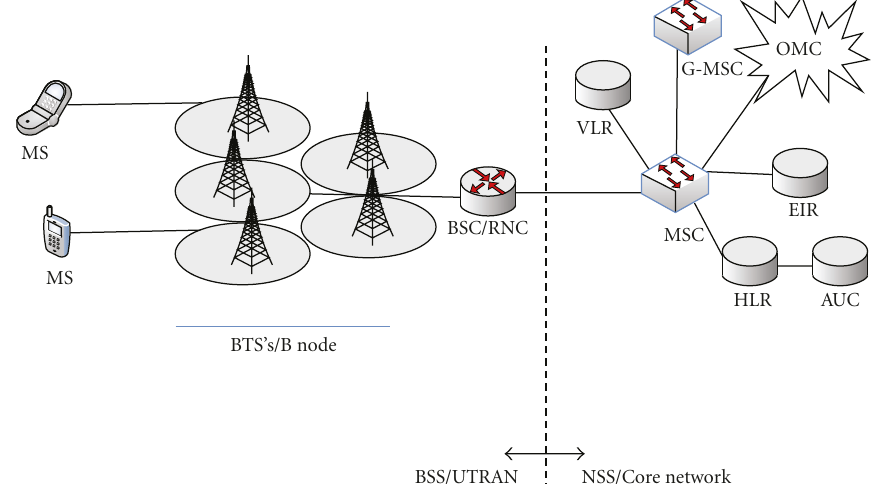
Figure 2: Mobile network general